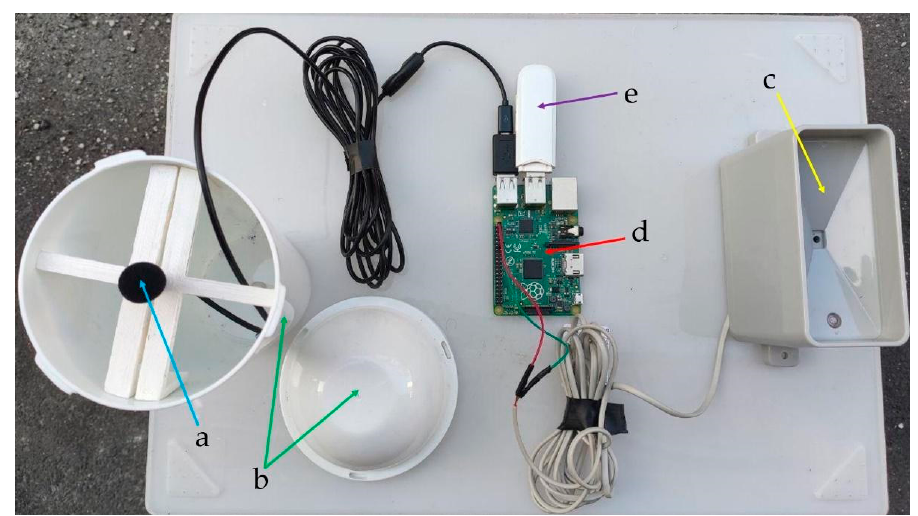
Figure 2. Hardware components.